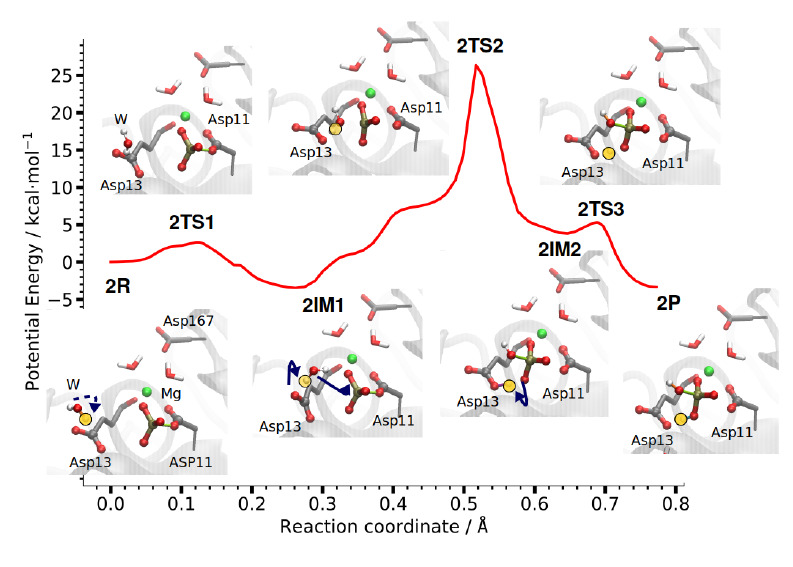
Figure 7. DFTB/MM energy profile of the second phosphate transfer step in PSP computed with CPR. The insets show active site residues of the reactant state, 2R, intermediate states 2IM1 and 2IM2, product state, 2P, and the transition states connecting them. The transferred proton is highlighted in yellow. Arrows indicate the transitions: The nucleophilic water molecule approaches the phosphate group and orientates for attack. The dissociation of the phosphoryl-aspartate and nucleophilic attack take place concertedly through a dissociative transition state, 2TS2. Upon the nucleophilic attack, a proton is transferred to Asp13 from the nucleophilic water molecule. The final step is the transfer of this proton from Asp13 to the phosphate